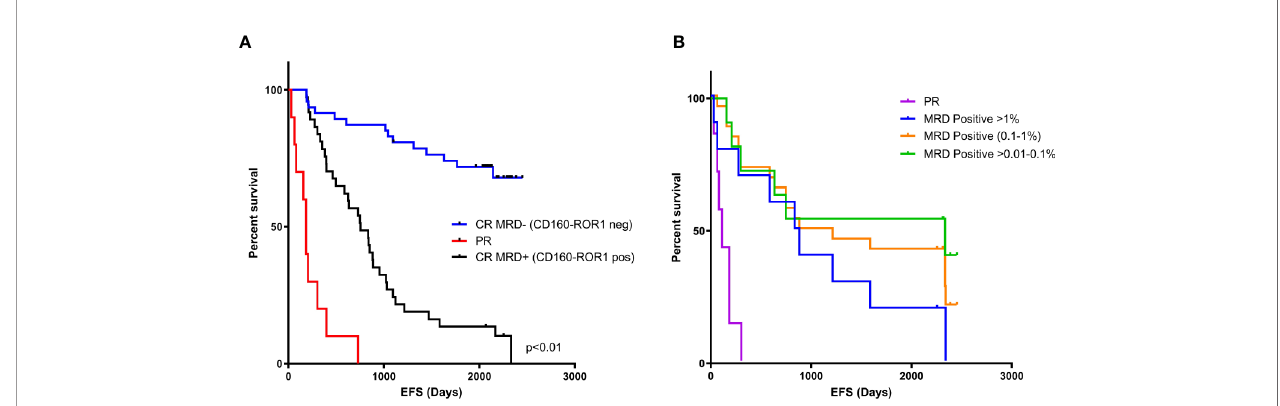
FIGURE 6 | MRD negativity byCD160-ROR1FCA correlates with event-free survival. Event-free survival (EFS)was assessedagainst MRD statusmeasured by CD160- ROR1FCA. (A) EFSof patients inCR and MRDnegative <0.01% (blue line, daysnot reached), CR andMRD positive >0.01% (black line, 756 daysp < 0.01)and patients achievinga PR (red line, 113 days, p < 0.01). (B) Levelof MRDand EFS: >0.01 to 0.1% (green line) 2,333 daysversus0.1 to 1% (orange line) 1,049